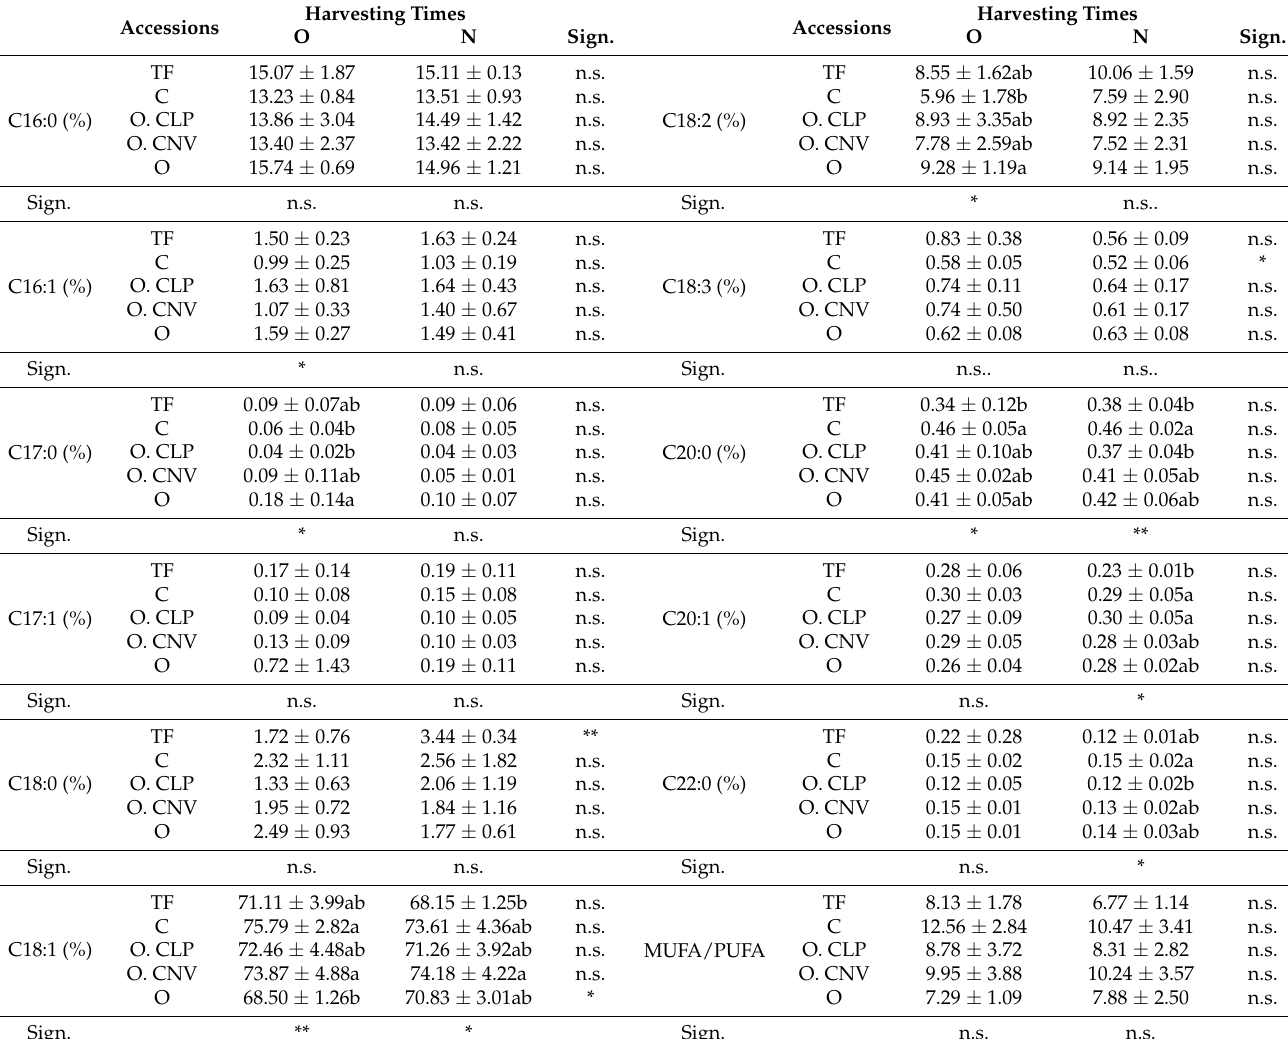
Table 2. Fatty acid compositions of olive oils of Tonda di Filogaso (TF), Ciciarello (C), Ottobratica Calipa. (O. CLP) Ottobratica Cannav à (O. CNV) and Ottobratica (O) accessions. Harvesting Accessions